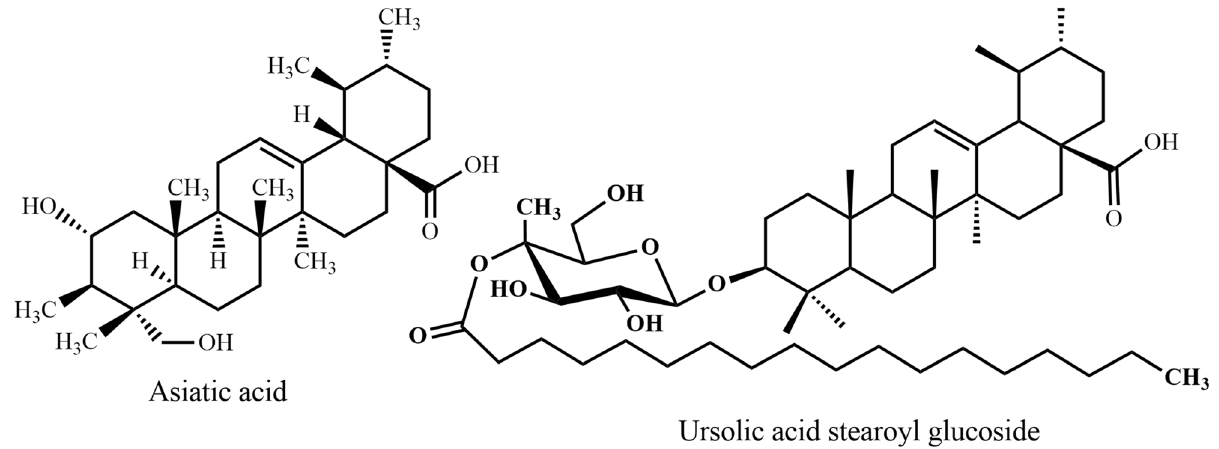
Fig. 8 Triterpenes 1: ursane